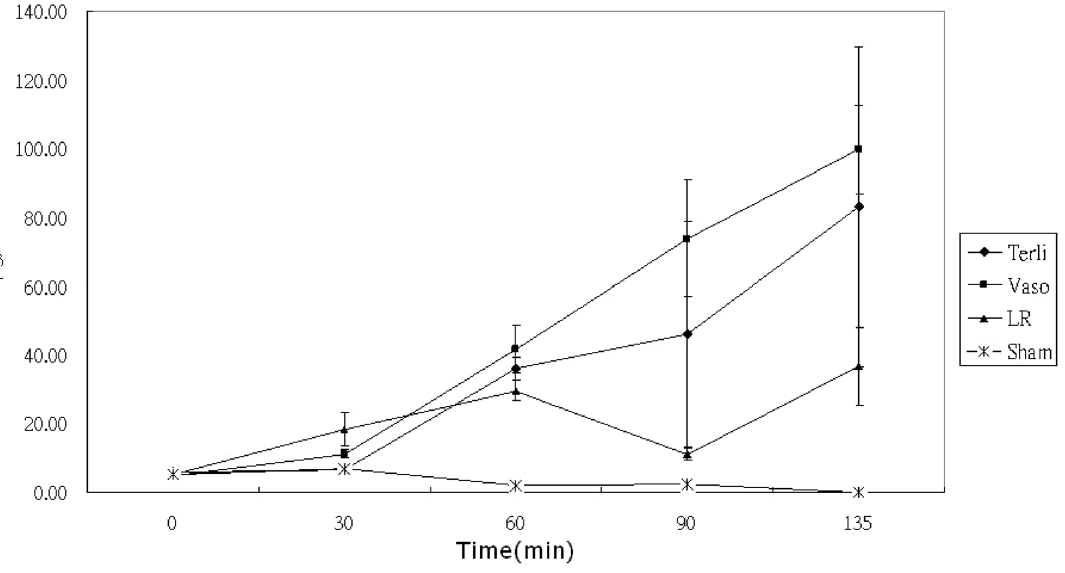
Figure 5. Comparison of serum IL-10 levels between different resuscitation strategies groups from 0 to 135 min. Data are shown as mean values and standard deviations. There were no significant differences in baseline levels. IL-10 production in the Terli and Vaso groups increased more significantly than in the LR or Sham groups (P , 0.001) but there was no significant difference of serum levels of IL-10 between the Terli and Vaso groups.